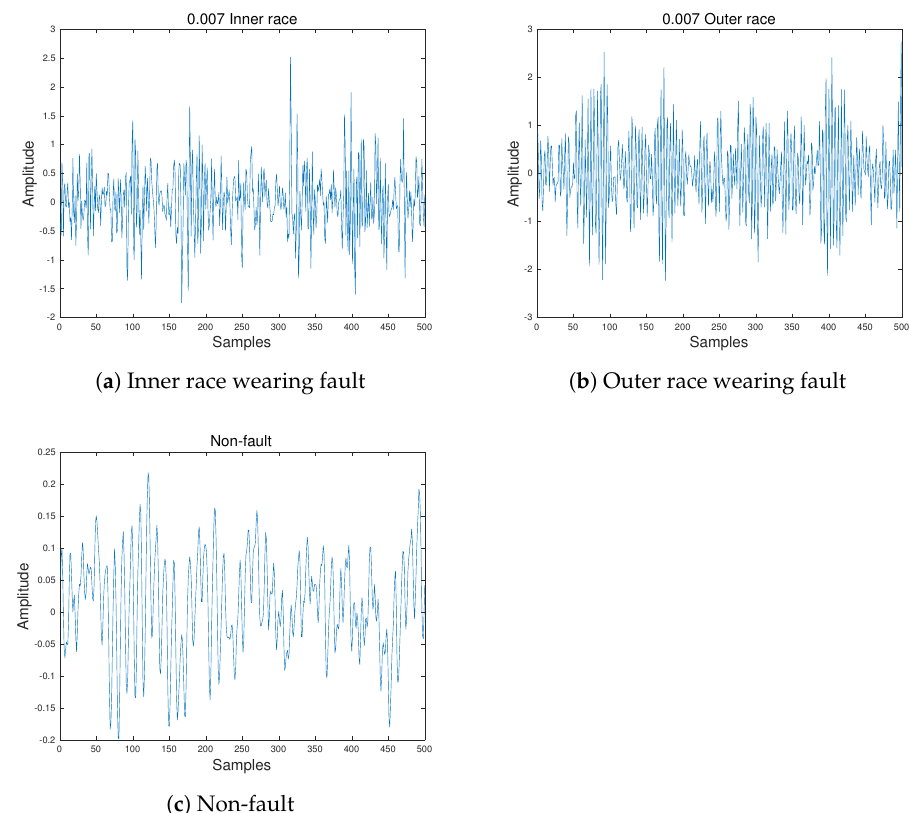
Figure 8. Vibration signals of two faults and non-fault in time-domain: ( a ) vibration signal of inner race wearing in time-domain; ( b ) vibration signal of outer race wearing in time-domain; ( c ) vibration signal of normal bearing in